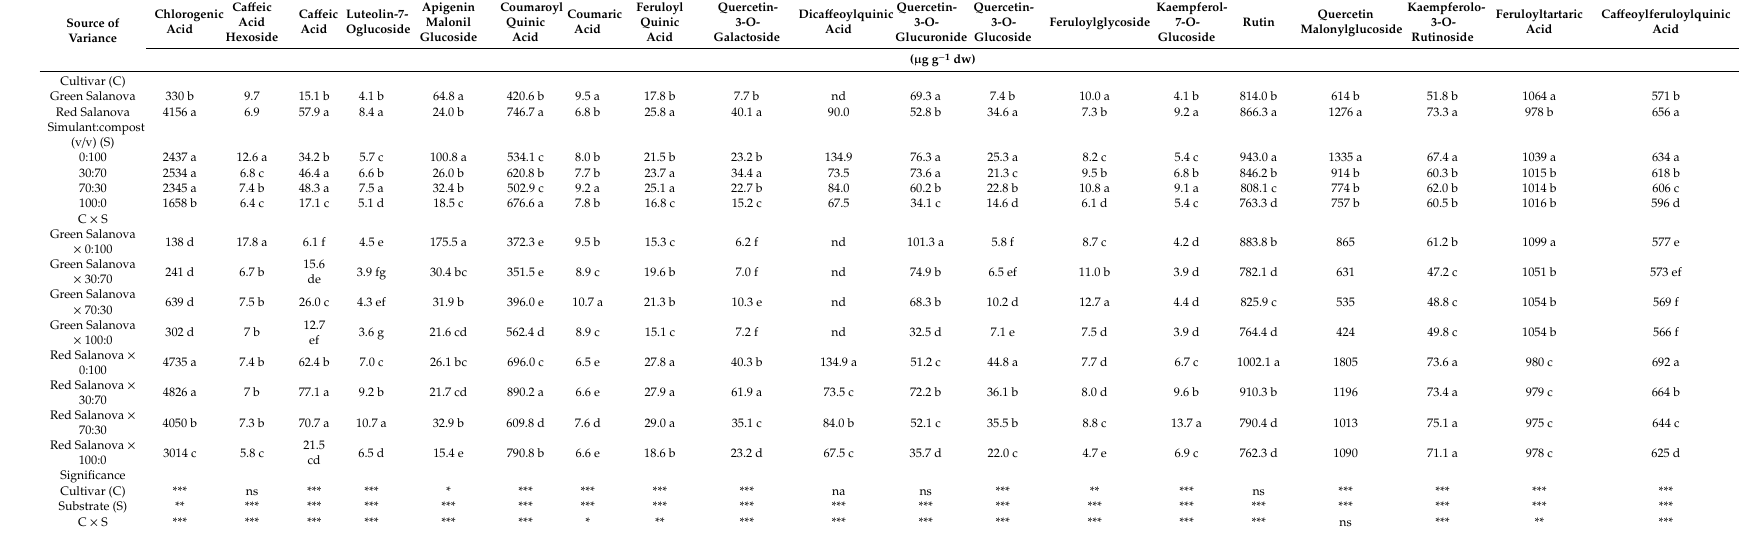
Table 3. Polyphenol profile of green and red Salanova lettuce, as influenced by substrate mixture (four di ff erent rates of MMS-1 simulant:compost v:v). Sourceof